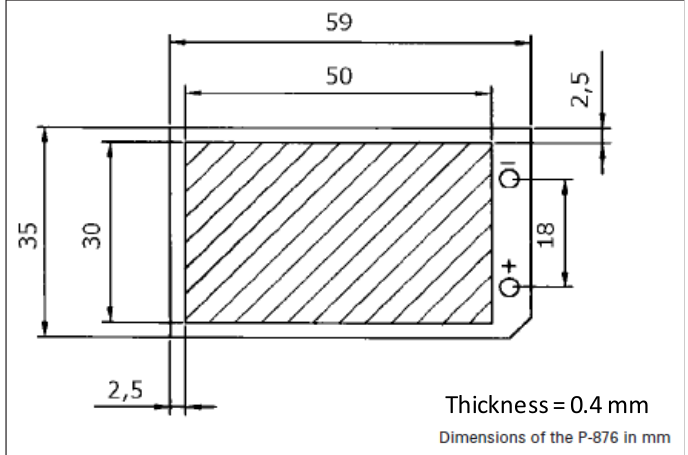
Figure 2. Dimensions of the P-876. A11 piezoelectric patch transducer. Published courtesy of PI Ltd.